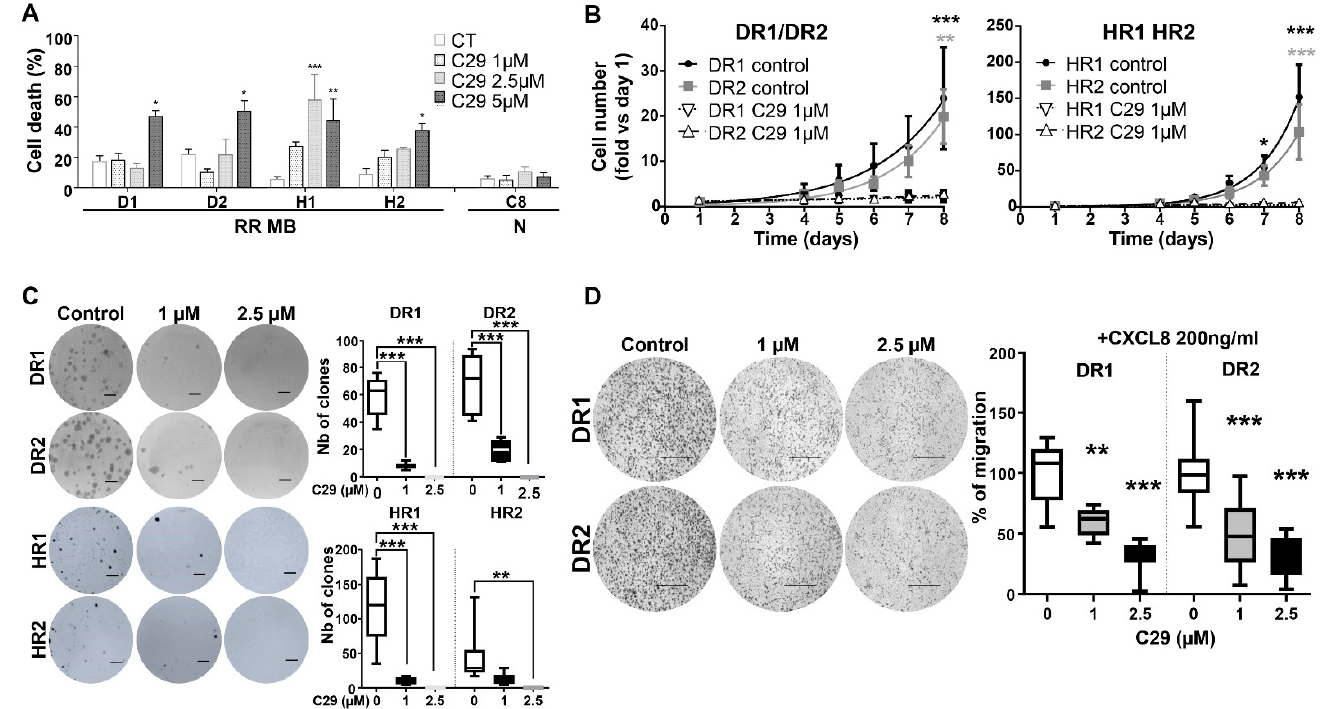
Figure 8. C29 is efficient on radioresistant MB cell lines. ( A ) Cell death after 48 h of treatment with control (DMSO, CT) or C29 1, 2.5, or 5 µ M on radiation-resistant cells (RR) and normal cells (N), n = 3. Statistics were performed using the one-way method ANOVA. * p < 0.05, ** p < 0.01, *** p < 0.001. For this figure, DR1 = D1, DR2 = D2, HR1 = H1, HR2 = H2, and C8D1A = C8. ( B ) Proliferation of DR1/DR2 ( A ) and HR1/HR2 ( B ) radio-resistant cells after 1 µM C29 treatment or control (DMSO), n = 3. ( C ) Clonogenic assay on DR1, DR2 (n = 3) and HR1, HR2 (n = 3) cells after treatment with control (DMSO) or C29 (1 µM or 2.5 µM). ( D ) Cell migration through the Boyden chamber of DR1 and DR2 cells specifically attracted by 200 ng/mL CXCL8. Cells were treated with control (DMSO) or C29 (1 and 2.5 µM). Results are expressed as percentage of control (n = 3). Scale = 1000 µm. Statistics were performed using Student t -test for 2 comparisons only or ANOVA test for multiple comparisons. * p < 0.05, ** p < 0.01, *** p < 0.001.